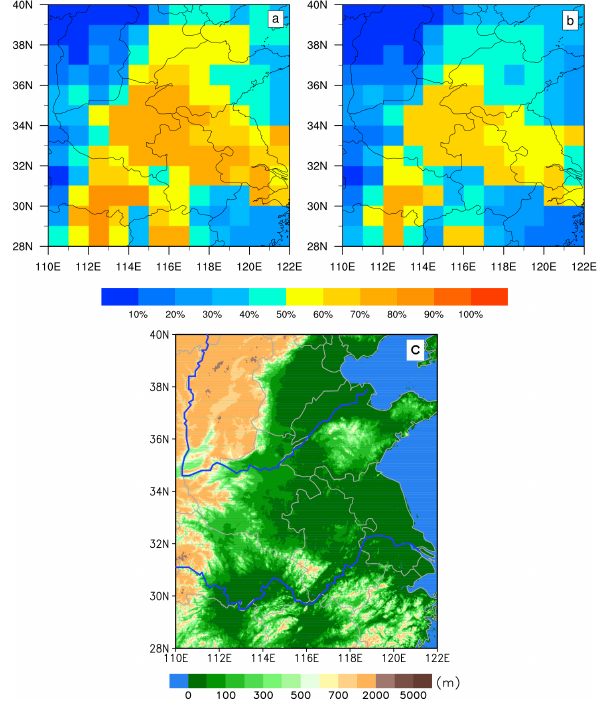
Figure 3. Frequency distribution of (a) AOD > 0.5 and (b) AOD > 0.6 in October calculated from 2001 to 2010; (c) the topography of eastern